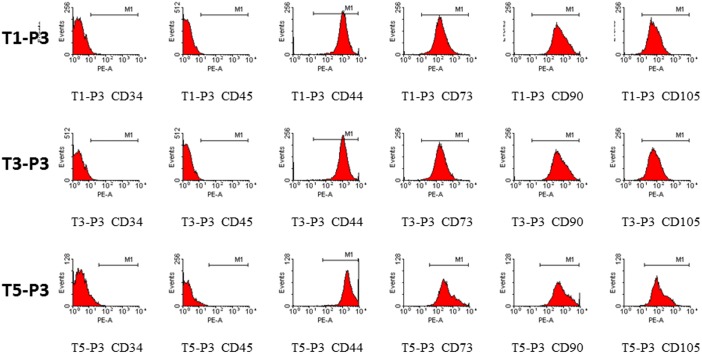
Immunophenotypic profiles of the T1-P3, T3-P3, and T5-P3 cells.